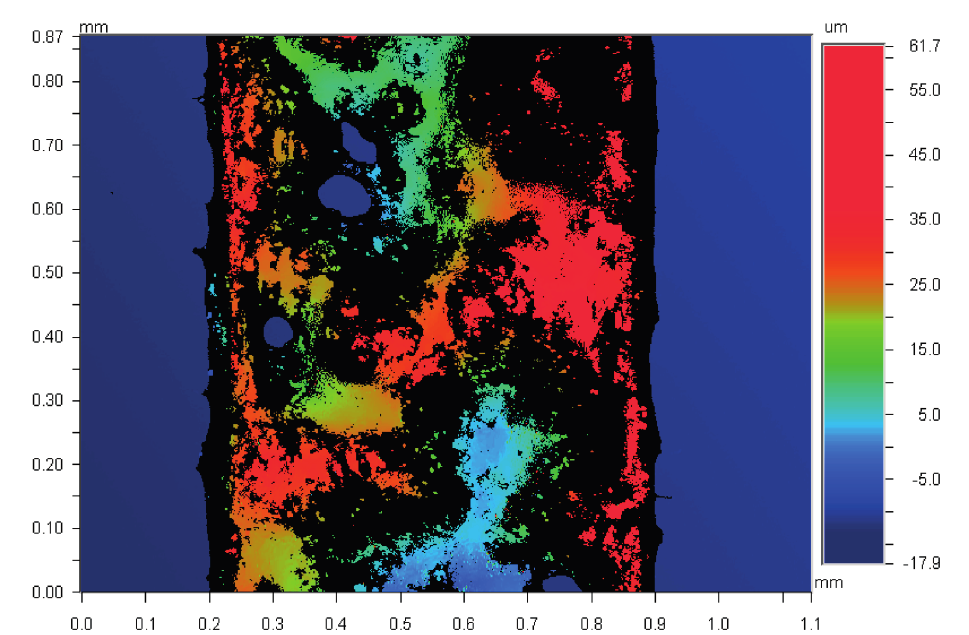
Figure 5. Optical profiler image of a printed liquid alloy